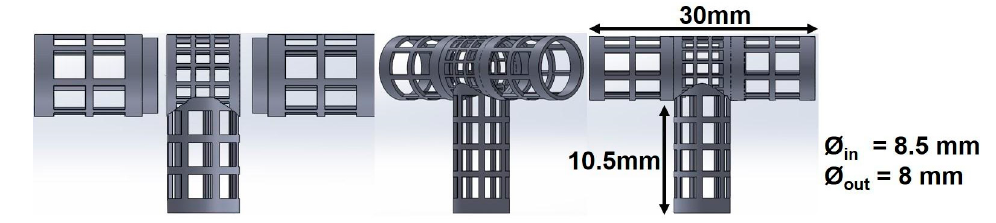
Figure 4. Dimensions of 3D printed bifurcating vascular graft mandrel.